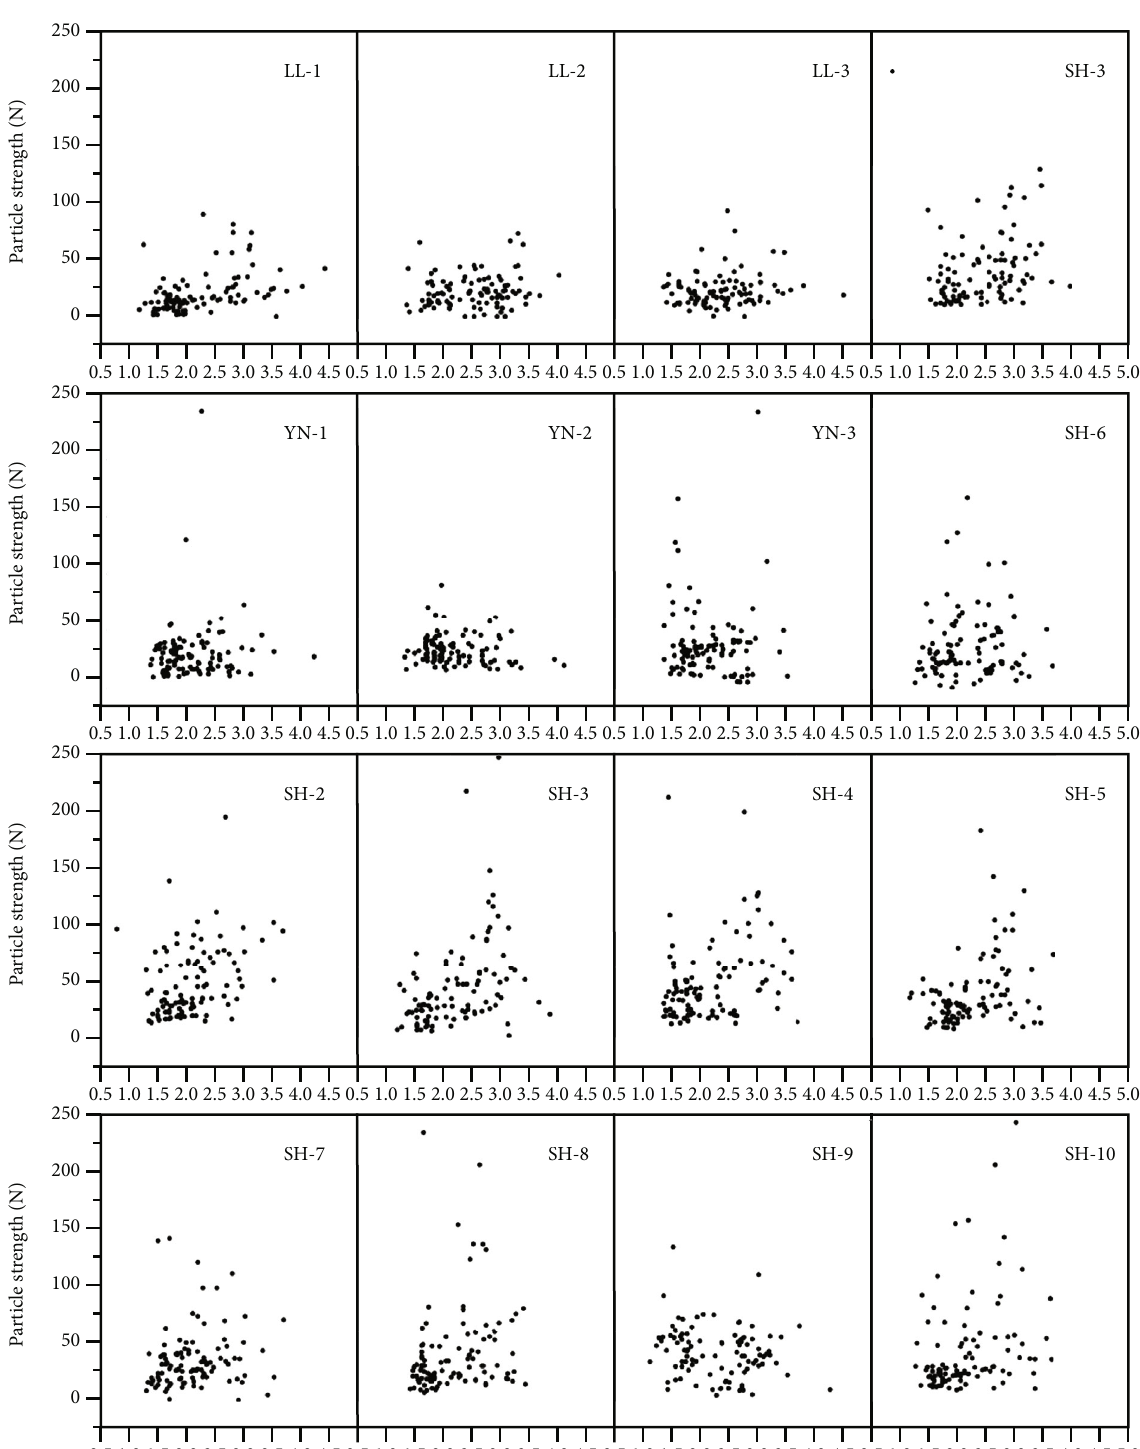
Figure 9: Scatter diagram of particle strength